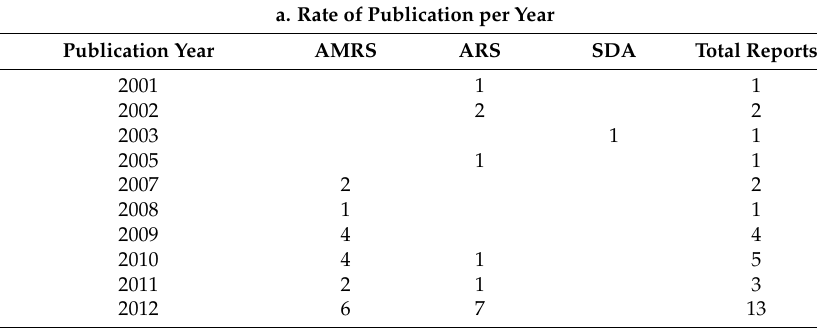
Table 1. Rate of publication per year ( a ) and population groups identified in the studies ( b